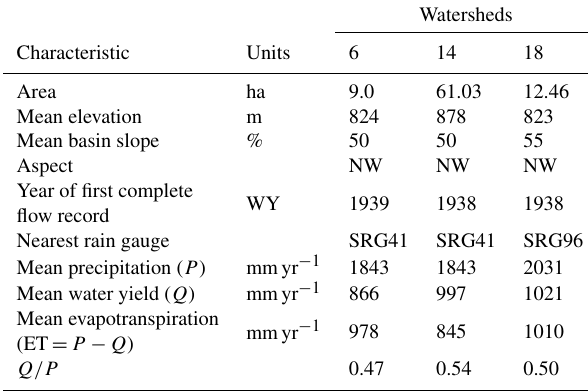
Table 1. Characteristics of treated (WS6) and reference (WS14, WS18) watersheds at the Coweeta Hydrologic Laboratory in Otto, NC, USA. Mean annual precipitation ( P ) and water yield ( Q ) based on data collected over water years (WY, May–April) from 1934 to